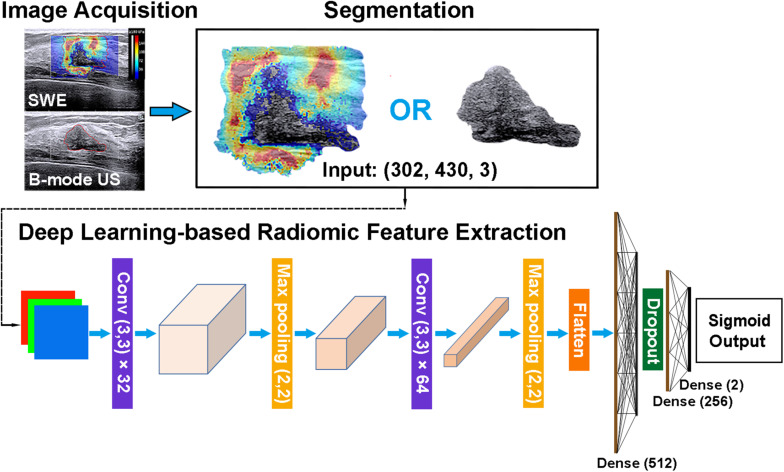
Major steps for the image acquisition, segmentation, and deep learning-based radiomic feature extraction method. SWE, shear-wave elastography; US, ultrasonography; and Conv, convolutional layer.